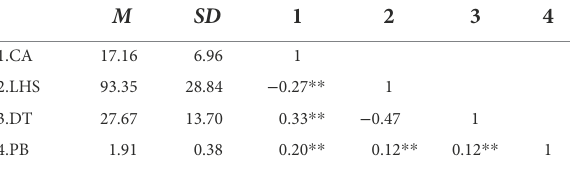
CA, childhood adversity; LHS, life history strategy; DT, dark triad; PB, problem behavior. * p < 0.05; ** p < 0.01.